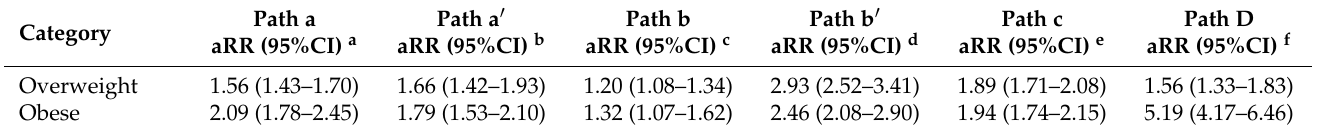
Table 3. The testing for significance of paths a, a (cid:48) , b, b (cid:48) , c, and